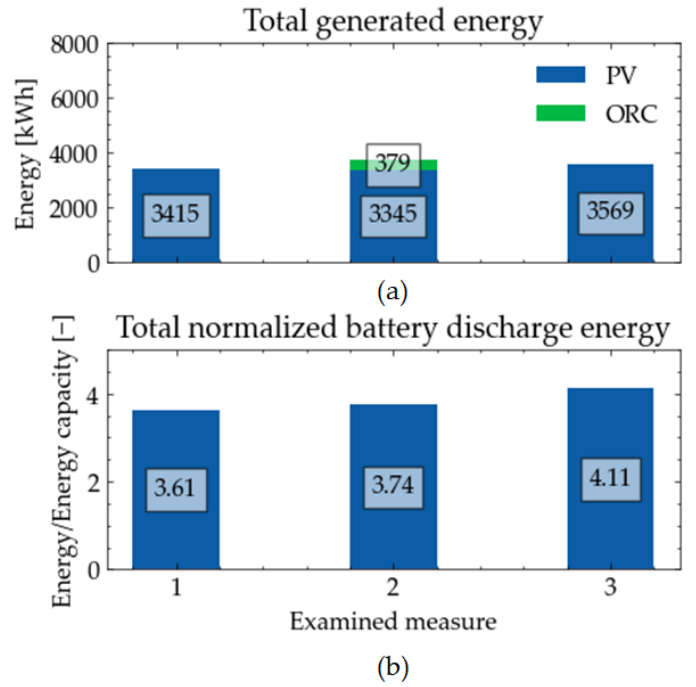
Figure 18. Total energy injected for each proposed measure by ( a ) RES and ( b ) battery system normalized to nominal discharge energy capacity.